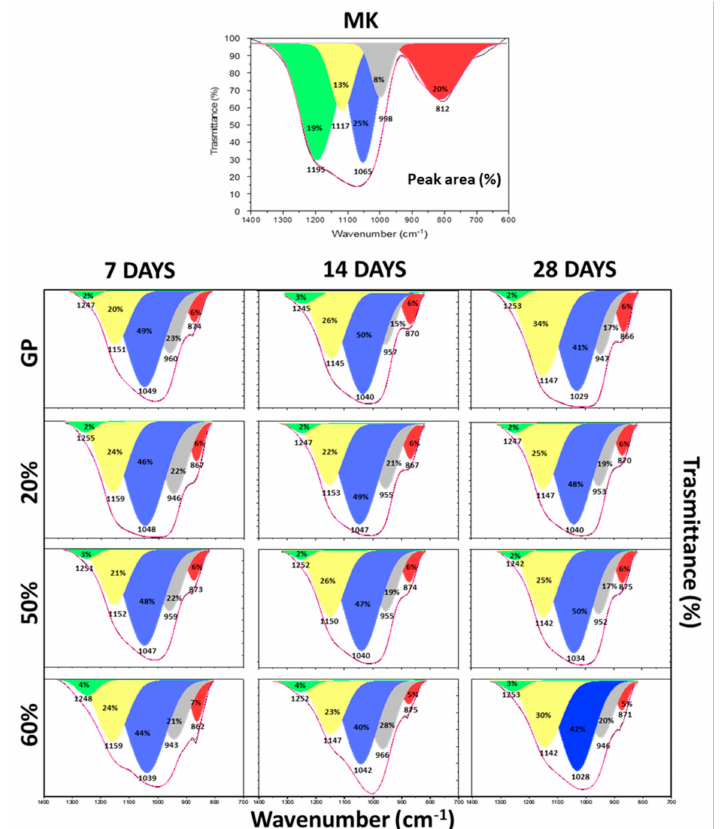
Figure 7. Deconvoluted DOSPM of FT-IR spectra of MK, GP, and GP/WG samples at different curing times. The percentages indicate the waste glass content.